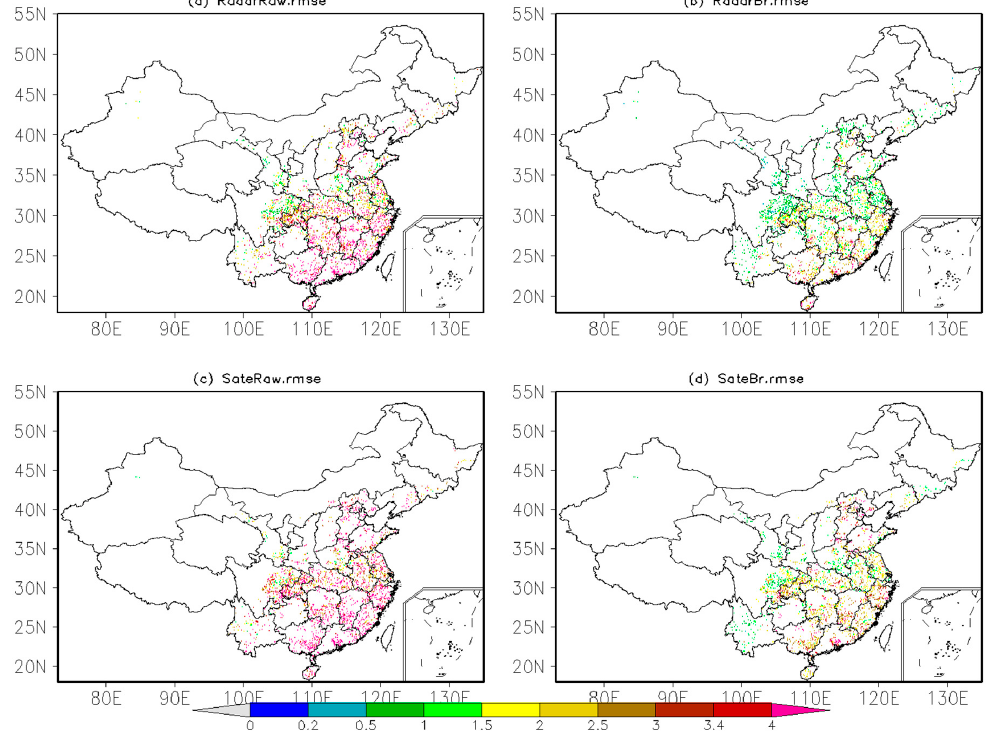
Figure 12. The same as Figure 11, but for